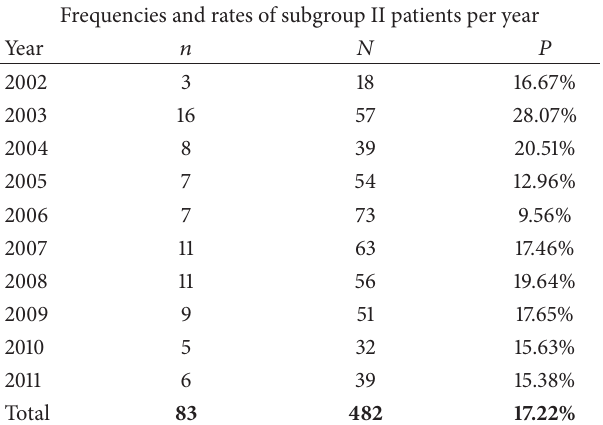
Table 1: Frequencies and rates of subgroup II patients per